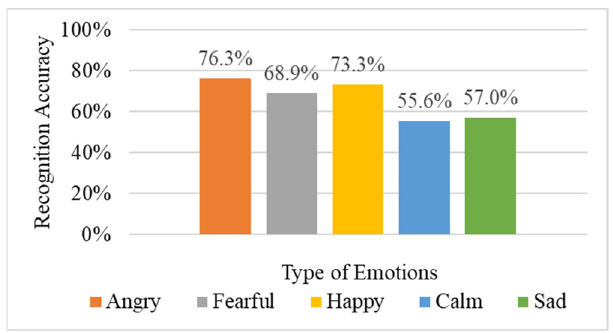
Figure 9. Results of the original method.